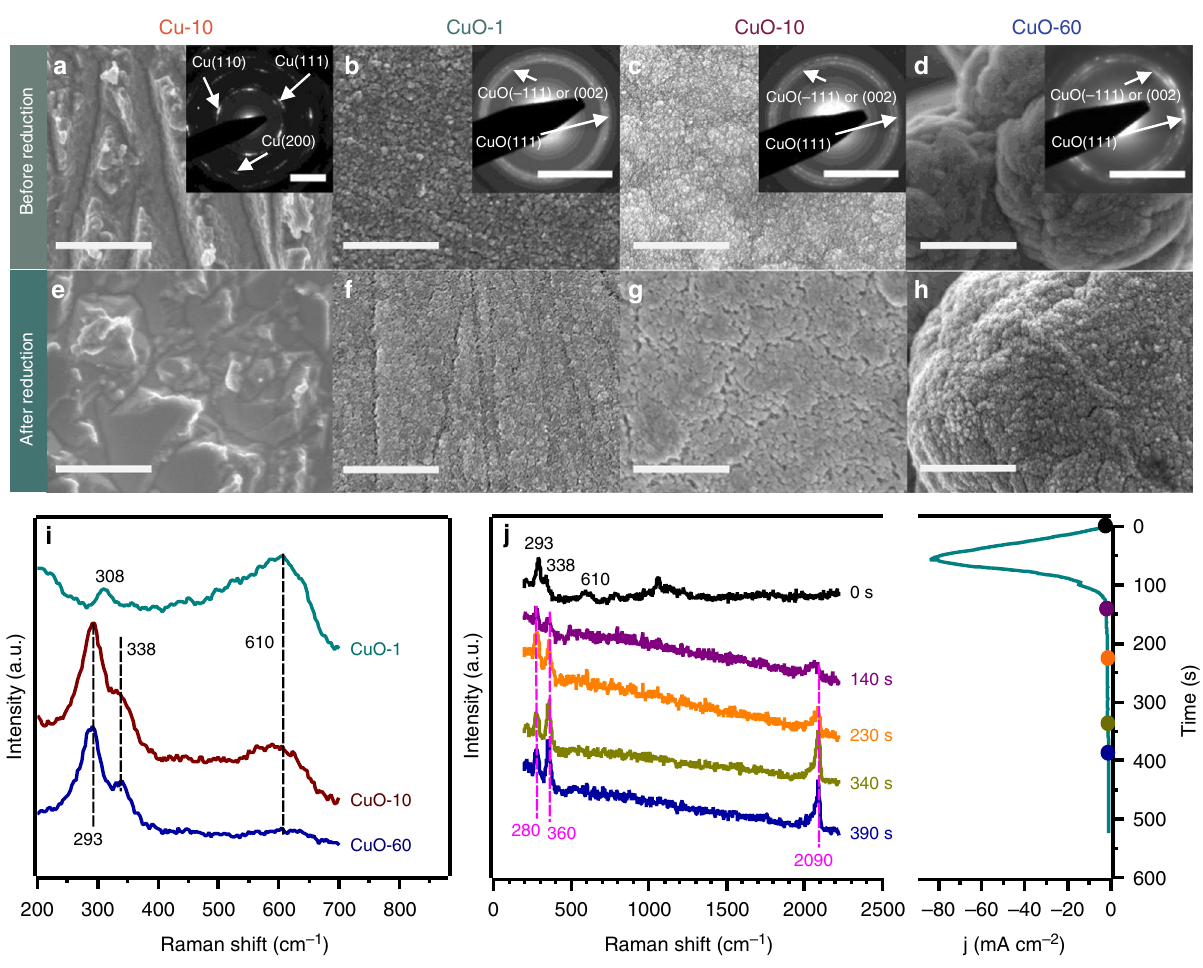
Fig. 1 Material characterization of four catalysts. SEM images and SAED patterns (inserts) of ( a ) Cu-10, ( b ) CuO-1, ( c ) CuO-10, and ( d ) CuO-60 catalysts before reduction; SEM images of ( e ) Cu-10, ( f ) CuO-1, ( g ) CuO-10, and ( h ) CuO-60 catalysts after reduction; ( i ) Raman spectra of Cu oxide surfaces collected ex situ and ( j ) operando Raman spectroscopy with the simultaneously obtained chronoamperogram of CuO-60 during CO 2 reduction in 0.1 M KHCO 3 at − 0.5 V vs. RHE. Scale bars: 1 μ m for SEM ( a – g ) and 5 nm − 1 for SAED (inserts of a – d